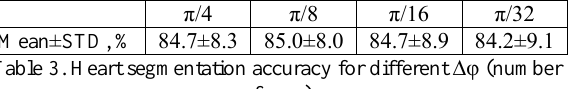
Table 5. Brain tumour segmentation accuracy for different ∆φ (number of